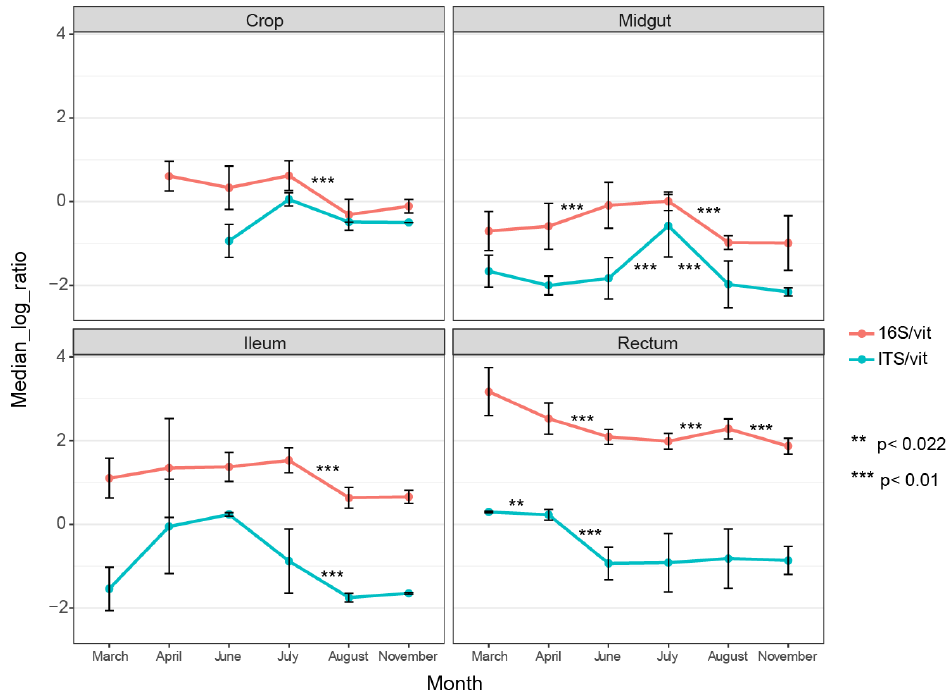
Figure 1. qPCR results showing median relative abundance of bacteria (16S) and fungi (ITS1) across months per gut part. Both 16S and ITS1 gene DNA are normalized against vitellogenin gene DNA. The vitellogenin gene copies were used as a proxy for the weight of the tissue. Error bars represent standard deviations. The asterisks represent statistical significance using the Wilcoxon signed-rank test.